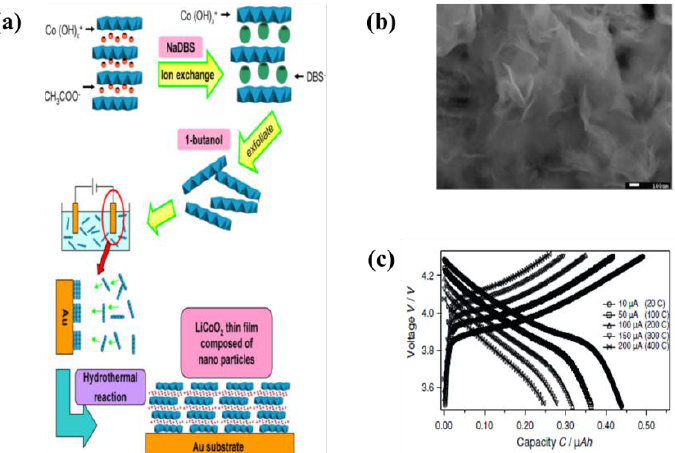
Figure 6. LiCoO 2 thin film prepared by EPD as the cathode for Li ion batteries: ( a ) Synthesis of nanosized LiCoO 2 by nanosheet restacking and subsequent hydrothermal method; ( b ) SEM image of the surface of the films with 5 min EPD; ( c ) Charge-discharge curves of 5 min deposited sample at various currents.